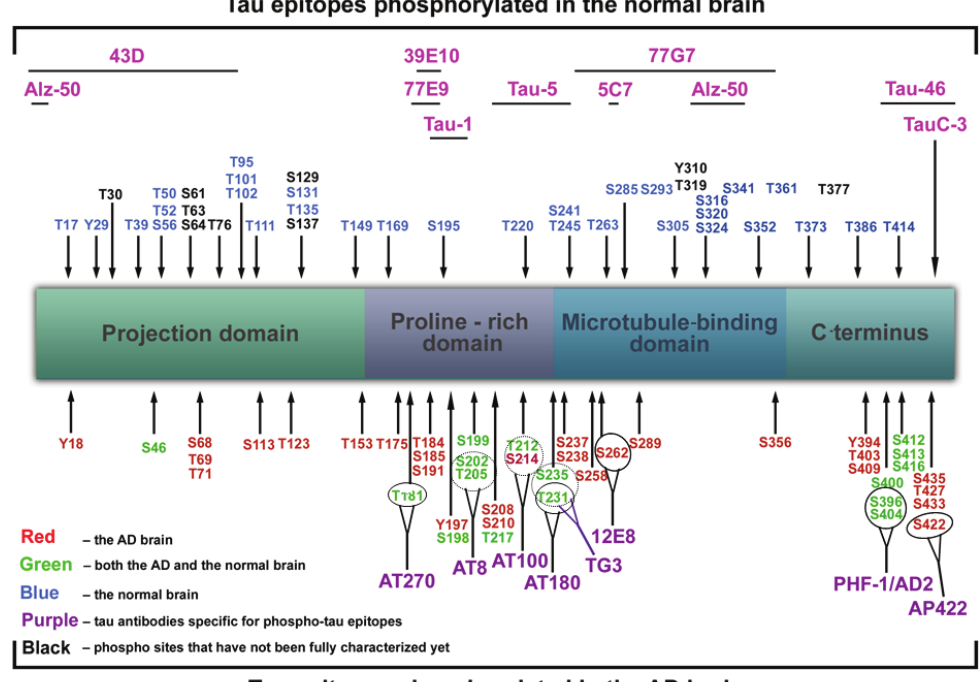
Figure 3. Putative phosphorylation sites on tau protein and epitopes specific for major tau antibodies. Red color denotes amino acids phosphorylated in AD brain, green in both AD and normal brain, blue in normal brain, while black color means that those phosphorylation sites have not been fully characterized yet. Tau antibodies specific for phospho-tau epitopes are given in purple, while pink color denotes antibodies specific for non-phosphorylated tau epitopes: Alz-50 (aa 2–10, aa 312 ´ 342), 43D (aa 1–100), 77E9 (aa 185–195), 39E10 (aa 189–195), Tau-5 (aa 210–230), 5C7 (aa 267–278), Tau-1 (aa 195, 198, 199 and 202), 77G7 (aa 270–375), Tau-46 (aa 404–441), TauC-3 (tau cleaved on aa 421). Red—in the AD brain; Green—in both the AD and the normal brain; Blue—in the normal brain; Black—phosphorylation sites that have not been fully characterized yet; Purple—tau antibodies specific for phospho-tau epitopes; Pink—tau antibodies specific for unphosphorylated tau epitopes.